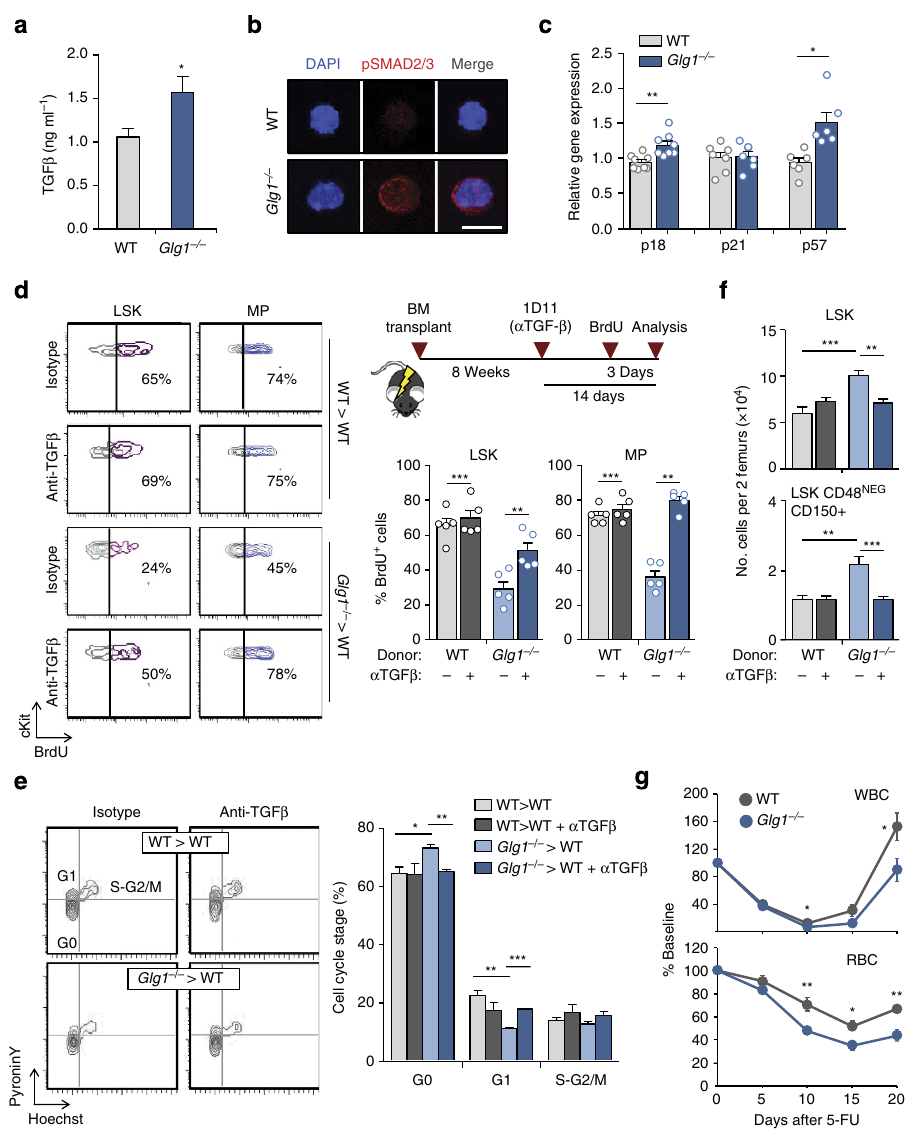
Figure 3 | ESL-1 controls HSPC proliferation by repressing TGF b secretion. ( a ) TGF b levels in the BM of WT and Glg1 (cid:2) / (cid:2) -transplanted mice; n ¼ 8. ( b ) Micrographs of purified WT and Glg1 (cid:2) / (cid:2) LSK cells stained for pSMAD2/3 (red) and DAPI (blue). Scale bar, 5 m m. Data are from two independent experiments. ( c ) Expression of p18, p21 and p57 in sort-purified WT and Glg1 (cid:2) / (cid:2) LSK cells; n ¼ 6–8. ( d ) Representative contour plots of BrdU incorporation in WTand Glg1 (cid:2) / (cid:2) LSK cells and MP treated with anti-TGF b or control antibody. Right, experimental design (top) and bar graphs (bottom) show the percentage of BrdU þ cells in the different groups; n ¼ 5. Each circle represents a mouse. ( e ) Representative plots and quantification of cell cycle analyses of WT and Glg1 (cid:2) / (cid:2) LSK cells and MP from mice treated with anti-TGF b or control antibody; n ¼ 6. ( f ) Absolute numbers of the indicated progenitor populations in mice reconstituted with WT or Glg1 (cid:2) / (cid:2) marrow, and treated or not with anti-TGF b antibody; n ¼ 5. ( g ) Recovery kinetics of leukocytes (WBC) and erythrocytes (RBC) in the blood of mice reconstituted with WTor Glg1 (cid:2) / (cid:2) BM after treatment with a single dose of 5-FU; n ¼ 10. * P o 0.05; ** P o 0.01; *** P o 0.001 determined by Student’s test ( a , g ), Wilcoxon matched-pairs ( c ) or one-way analysis of variance with Turkey’s test ( d , e , f ). Data are show as mean ± s.e.m. reduced in Glg1 (cid:2) / (cid:2) cells and this could also be reverted by blocking TGF b (Fig. 5e and Supplementary Fig. 7c), indicating that early progenitors are an active source of inhibitory TGF b . Importantly, and agreeing with the role of ESL-1 in limiting posttranslational processing of pro-TGF b 8 , we did not find changes in Tgfb1 transcript levels in mutant LSK cells (Supplementary Fig. 8a), and in contrast found mild elevations in the levels of latent TGF b on the surface of Glg1 (cid:2) / (cid:2) progenitors compared with WT cells (Supplementary Fig. 8b). Because Glg1 (cid:2) / (cid:2) cells induced quiescence on neighbouring WT HSPC in vivo (Fig. 2), we sought to reproduce this We finally explored whether the repressive signals originating NATURE COMMUNICATIONS|7:10222|DOI: